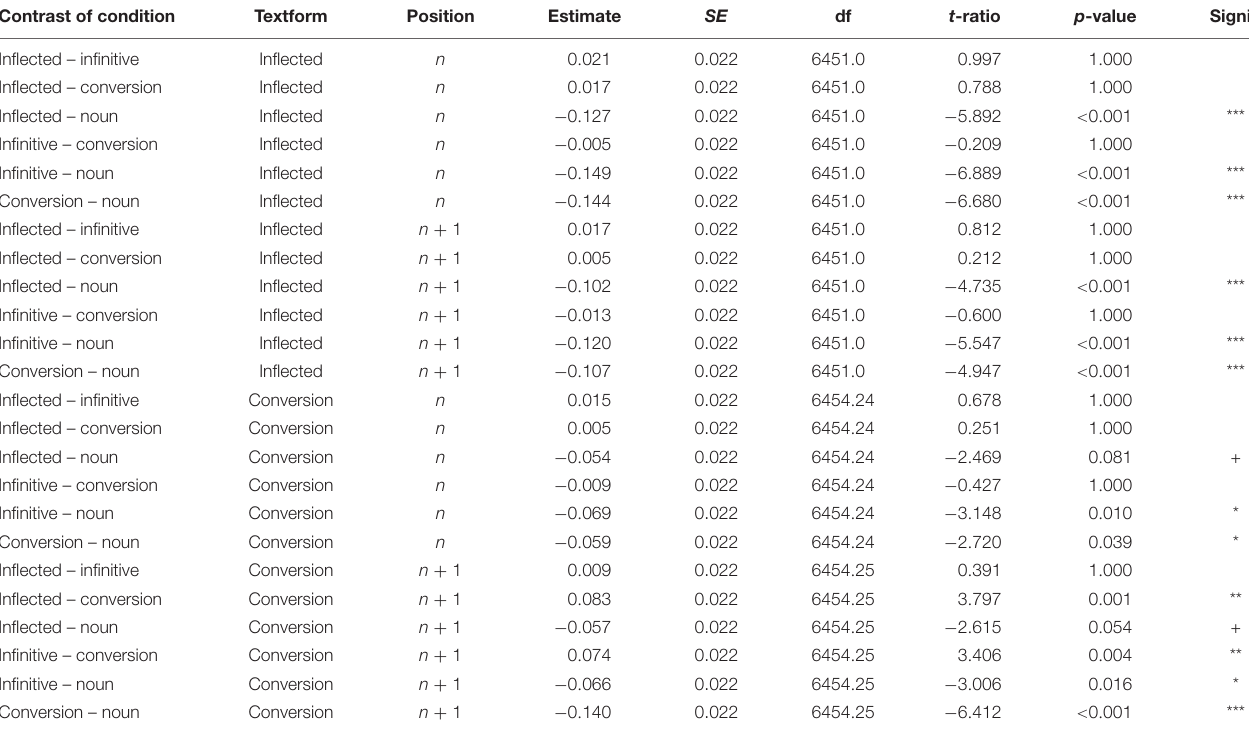
TABLE 5 | Pairwise contrasts of estimated marginal means for the predictor ‘Condition’ (by Position and TextForm) for Experiments L1A and L1B (native participants). Contrast of